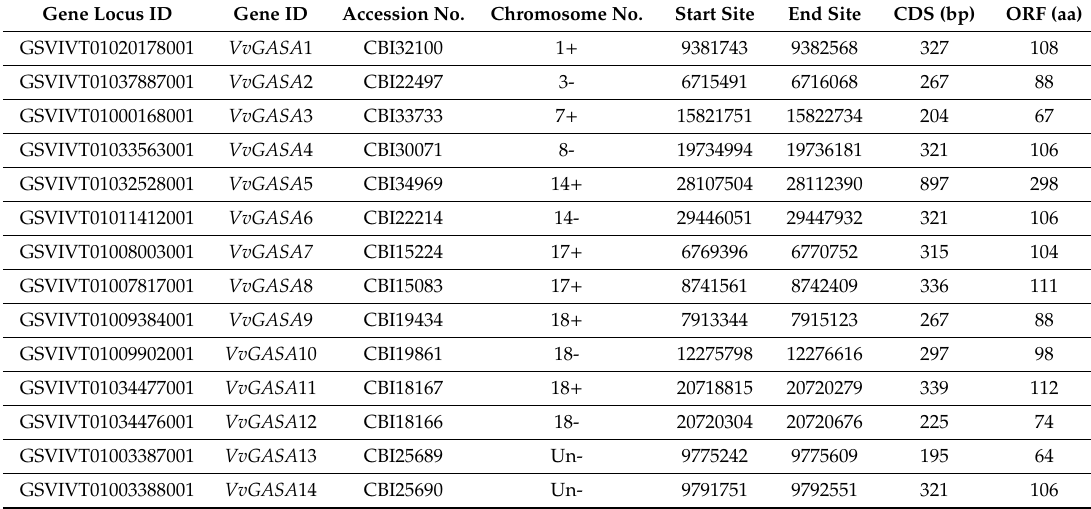
Table 1. Detailed information of grapevine GASA (gibberellic acid-stimulated Arabidopsis) genes. Gene Locus ID Gene